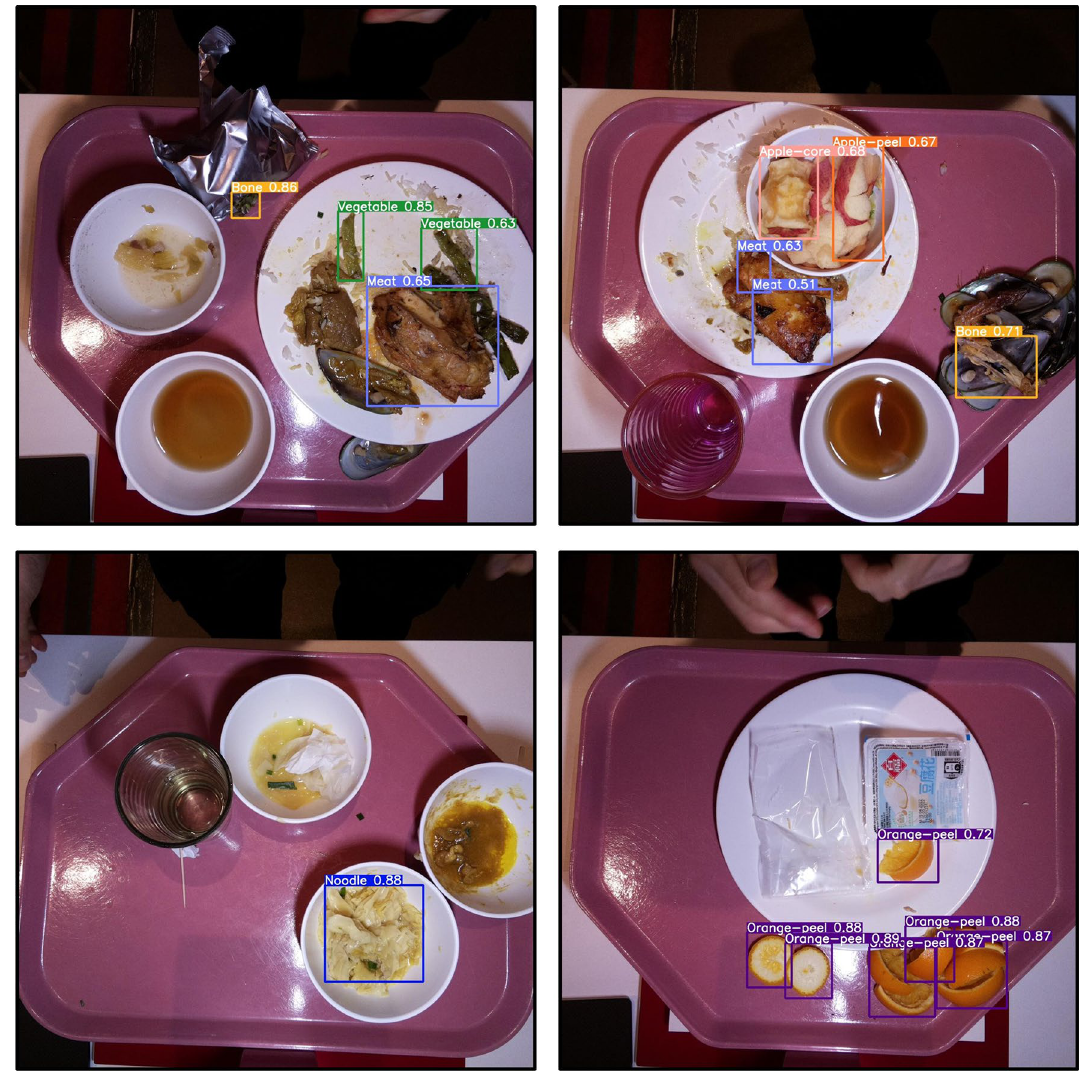
Figure 11. Example plate waste detection by YOLOv5m model on unseen test plate waste images captured by the plate waste tracker in Fig.